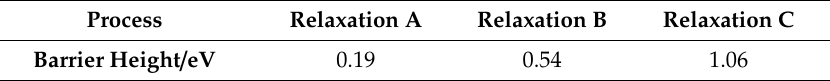
Figure 5. Measured TSDC spectrum and fitting curves for three current peaks for the oil-impregnated cellulose paper sample without bias voltage. Table 1. Barrier heights for relaxation processes based on the fitting result of TSDC.